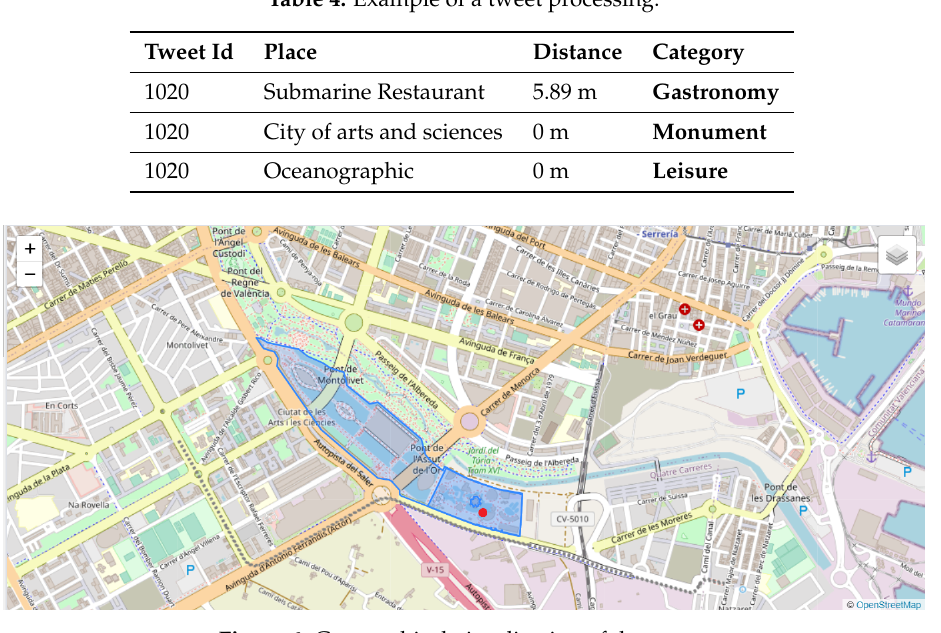
Figure 6. Geographical visualization of the